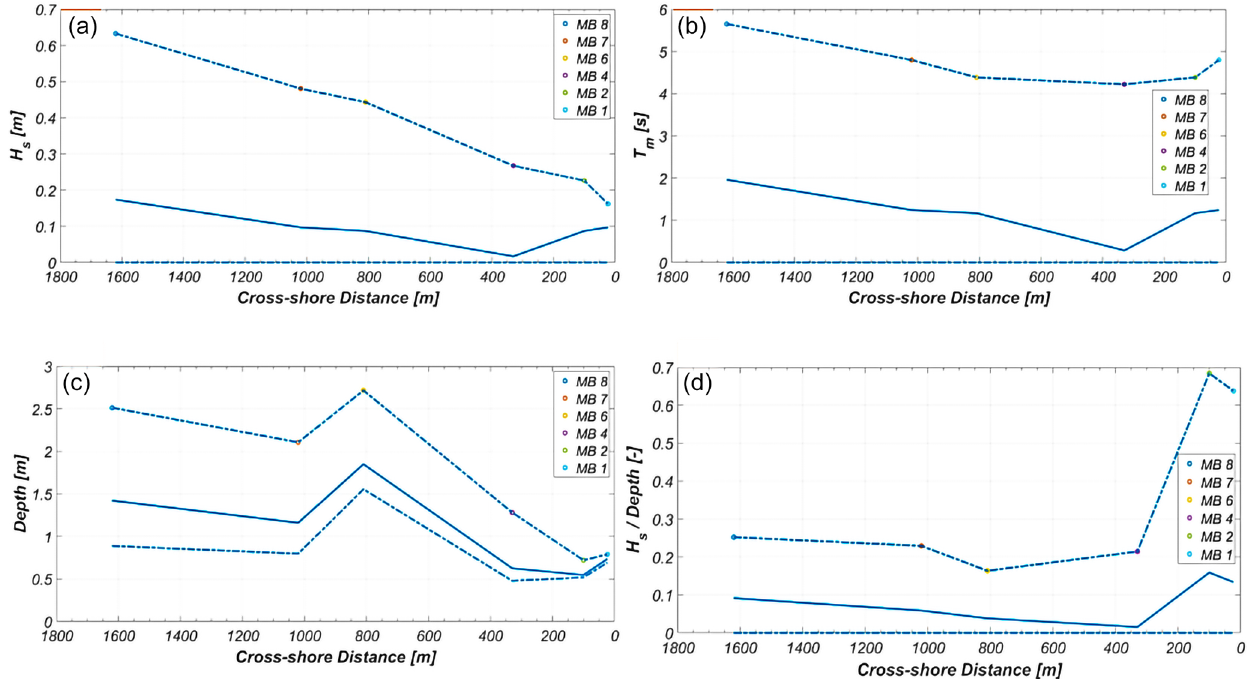
Figure 11. Spectral conditions along the transects: (a) significant wave heights H s [m], (b) mean wave periods T m [s], (c) depth [m] and (d) wave heights divided by water depths H s /d [−] . Plots of the wave characteristics present mean observed values, with bands representing the maximum and minimum values. Data comprise 5d of observations spanning deployment